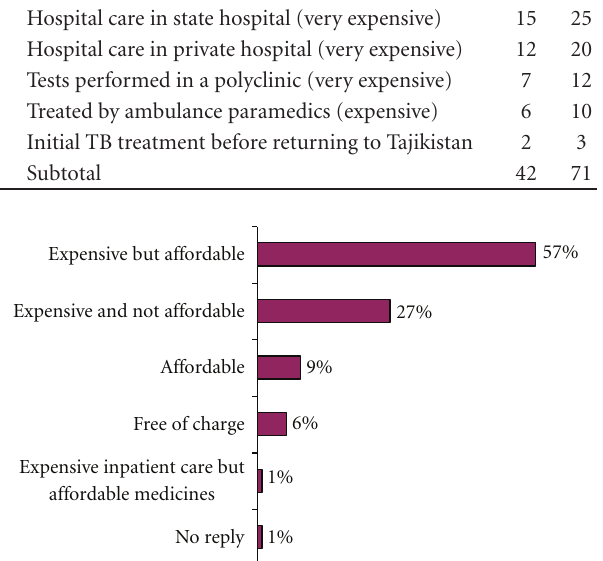
Figure 2: Perceived cost of medical services